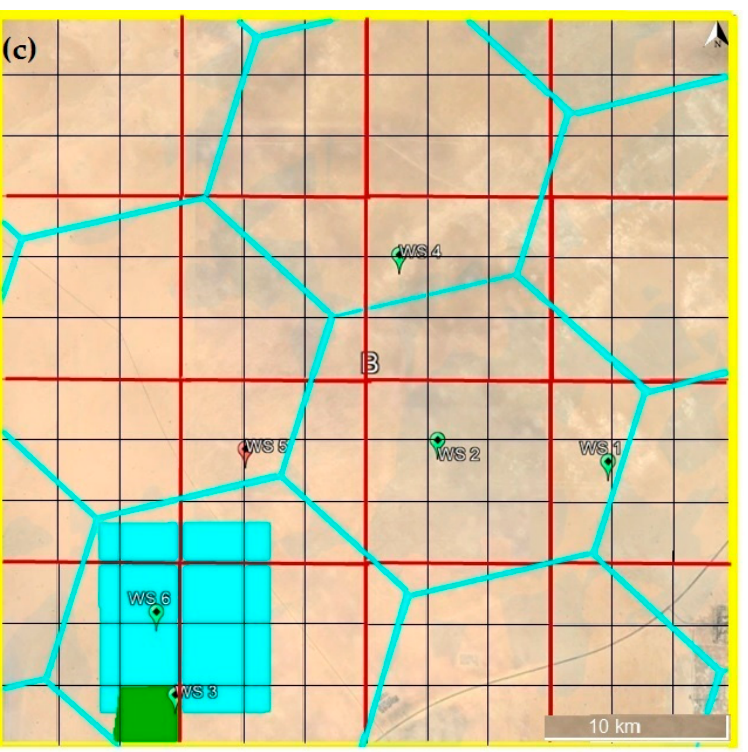
Figure 1. NASA SMAP Kuwait as candidate for Cal/Val. ( a ) SMAP proposed grids (A till G). ( b ) Weather stations with soil moisture sensors at different depths and thermogravimetric measure- ments. ( c ) SMAP Kuwait Cal/Val test site (B: 36 km full test grid [yellow]), square cyan filled (9 km test grid), square green (3 km validation grid), hexagonal cyan (SMOS 25 km × 25 km grid), red grid (SMAP 9 km × 9 km), smallest grid (SMAP 3 km × 3 km).